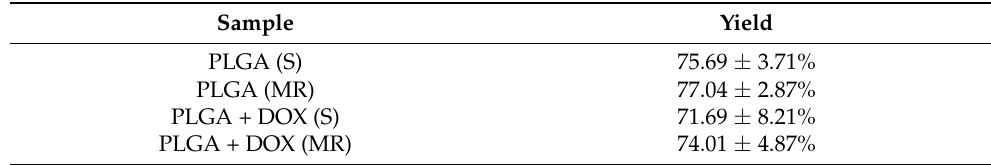
Table 1. Average yield of PLGA and PLGA + DOX microspheres mixed by sonication (S) and magnetic rotation (MR).